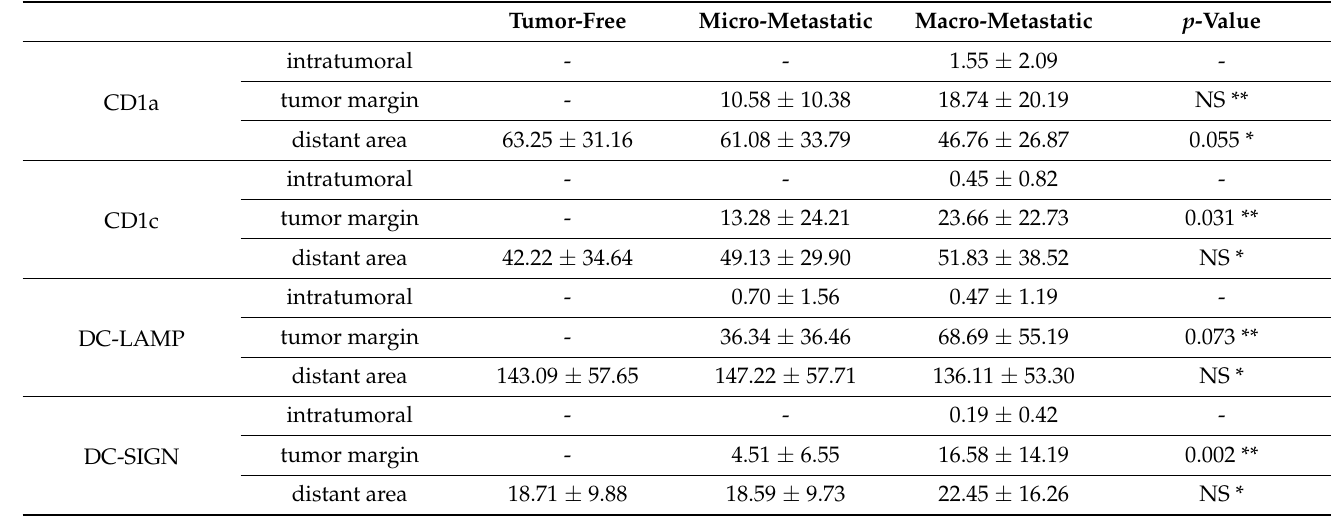
Figure 2. Infiltration of investigated DCs in SLNs. ( A ) CD1a+ DCs in SLN with macrometastasis. The majority of DCs are located in the distant area from the tumor and several are found at the tumor border (magnification 40×); ( B ) CD1a+ DCs observed intratumorally in BC macrometastasis (magnification 400×); ( C ) CD1c+ DCs in tumor-free SLN (magnification 40×); ( D ) CD1c+ DCs in tu- mor-free SLN (magnification 400×); ( E ) DC-LAMP+ DCs in SLN with micrometastasis. The DCs are located predominantly at the tumor border (magnification 40×); ( F ) DC-LAMP+ DCs observed in the area distant from micrometastasis (400×); ( G ) DC-SIGN+ DCs in SLN with macrometastasis. The DCs are located at the tumor border and in a distant area of the tumor (magnification 40×). ( H ) DC- SIGN+ DCs observed at the tumor border of macrometastasis (400×).